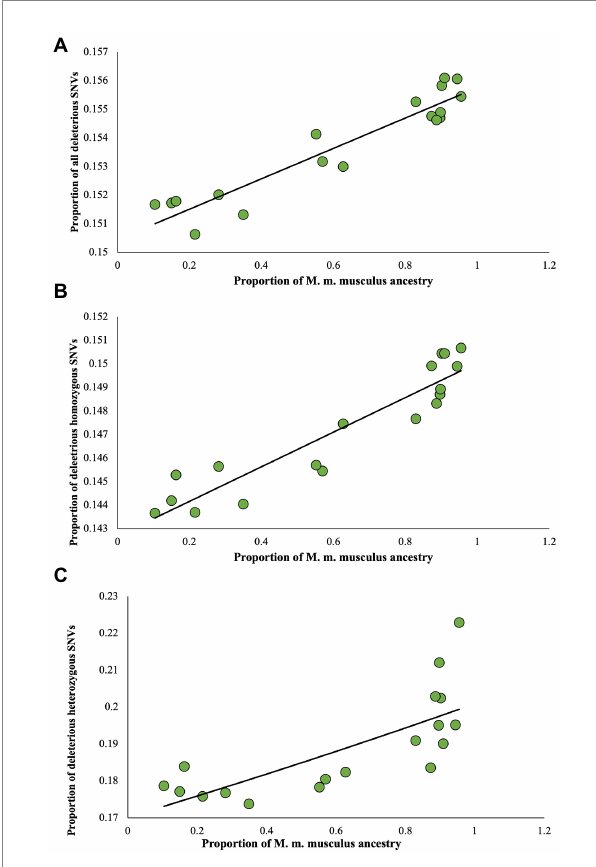
FIGURE 4 Relationship between the proportion of M. m. musculus ancestry/ admixture and the proportion of deleterious nSNVs estimated for admixed individuals. (A) All deleterious nSNVs, (B) Homozygous deleterious nSNVs, and (C) Heterozygous deleterious nSNVs. The relations were highly significant for all ( rho = 0.91, p < 0.00001), homozygous ( rho = 0.94, p < 0.00001), and heterozygous SNVs ( rho = 0.81, p < 0.0001). The best-fitting curves are shown.